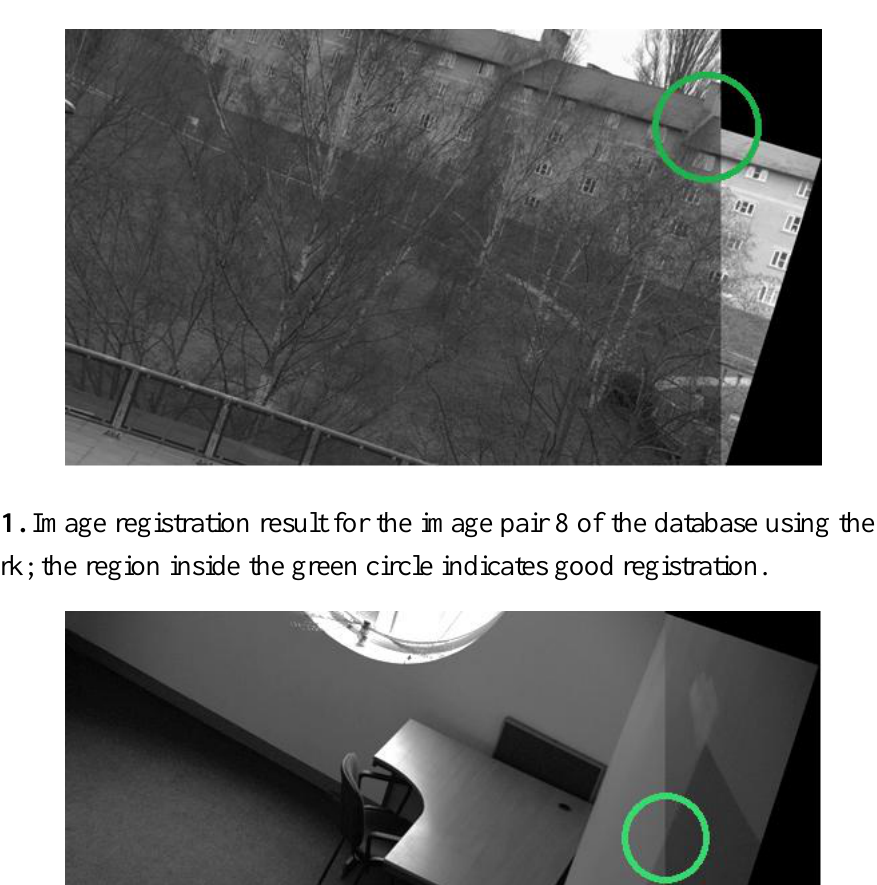
Figure 20. Image registration result for the image pair 7 of the database using the proposed framework; the region inside the green circle shows good registration.